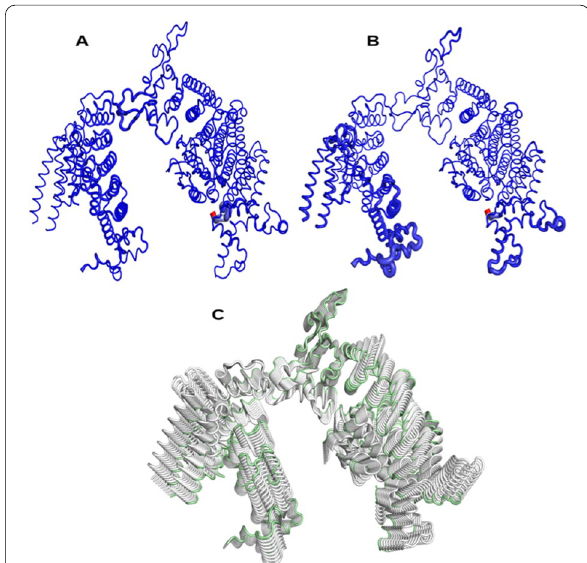
Fig. 8 Visual analysis of the hypothetical hs CENP-HIKM complex ( A ) deformation energy and ( B ) atomic fluctuation. The deformation and fluctuation magnitude is represented by the differential coloration of the 3D structure. Low, moderate and high deformation and fluctuation magnitudes are represented by the blue, white and red colors, respectively. ( C ) NMA-based representation of the trajectory for the first non-trivial mode of the hypothetical hs CENP-HIKM complex. The figure shows the superimposition of each mode in the trajectory